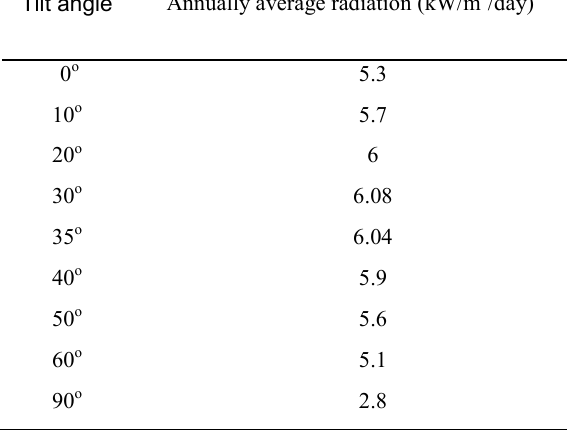
Table 3. Yearly solar radiation with different tilt angles